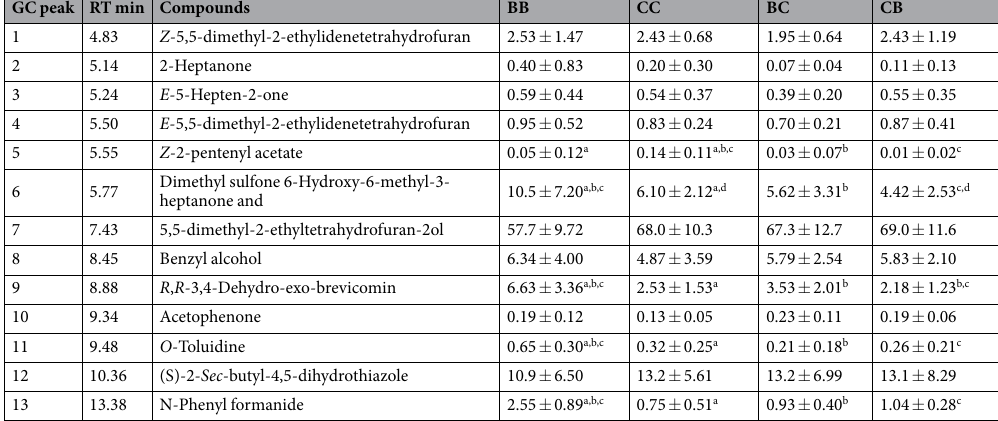
Table 2. Relative abundance of urinary volatiles in the four groups. Data are presented as mean ± SD, n = 8 for each group; compounds were identified using mass library (NIST 2002). a–f Means in a row marked by a same superscript letter show significant differences ( P < 0.05, using one-way ANOVA with LSD post hoc t-test or Kruskal–Wallis H with post hoc Mann–Whitney U test). BB: BALB/c strain; CC: C57BL/6 strain; BC: hybrid of